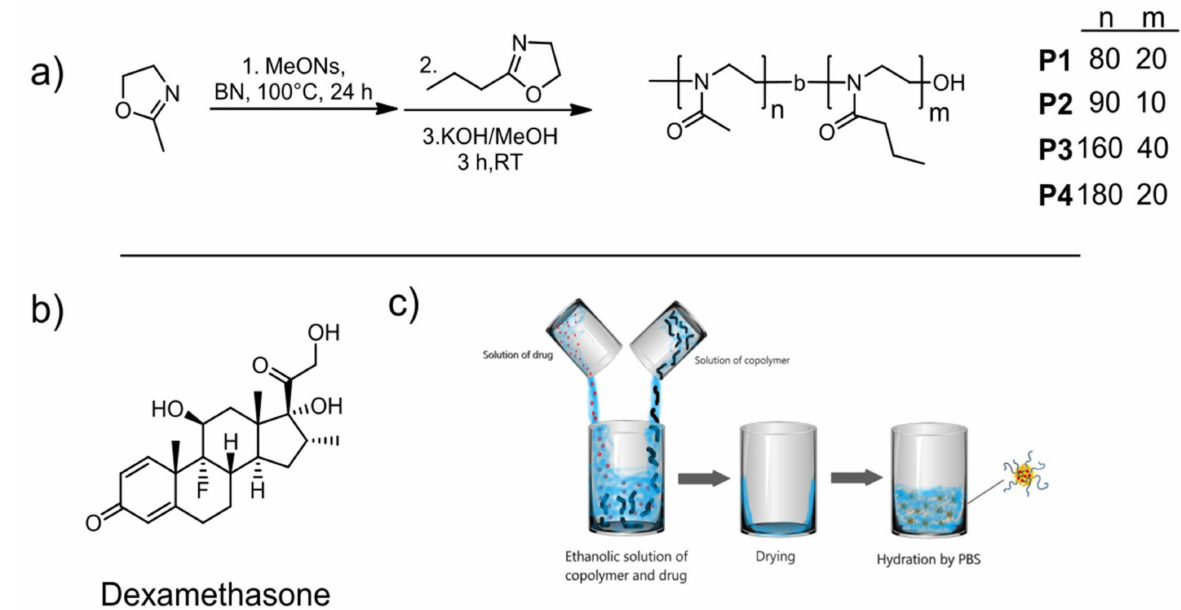
Figure 1. Reaction scheme of the synthesis of diblock copolymers P1–P4 ( a ). Chemical structure of dexamethasone ( b ). Depiction of encapsulation of drug by thin-film method ( c ). Table 1. Molecular characteristics of the prepared diblock copolymers compared to calculated theoretical values. Sample